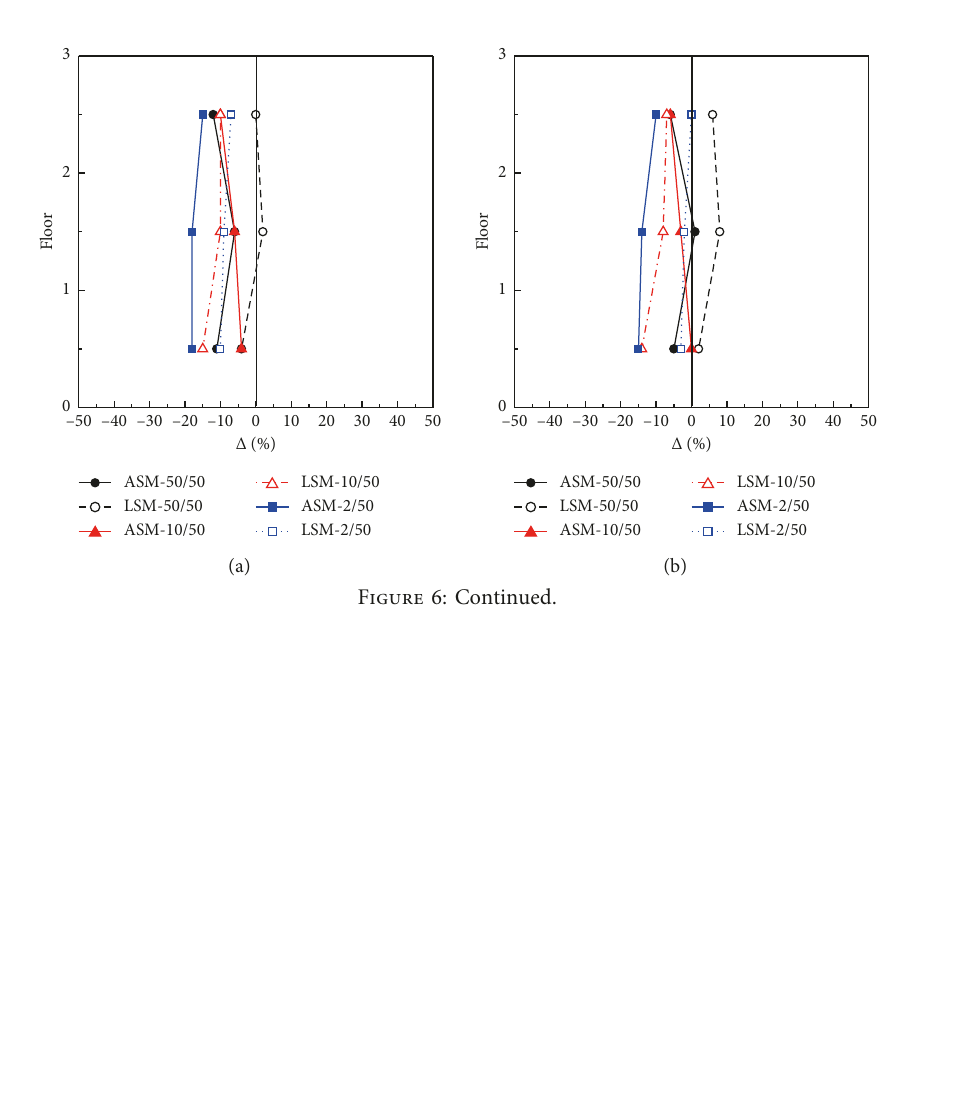
Figure 5: Global pushover curves for the 3-, 9-, and 20-story structures (scatter points with the same shape from left to right represent the benchmark mean demands at 50/50, 10/50, and 2/50 seismic hazard